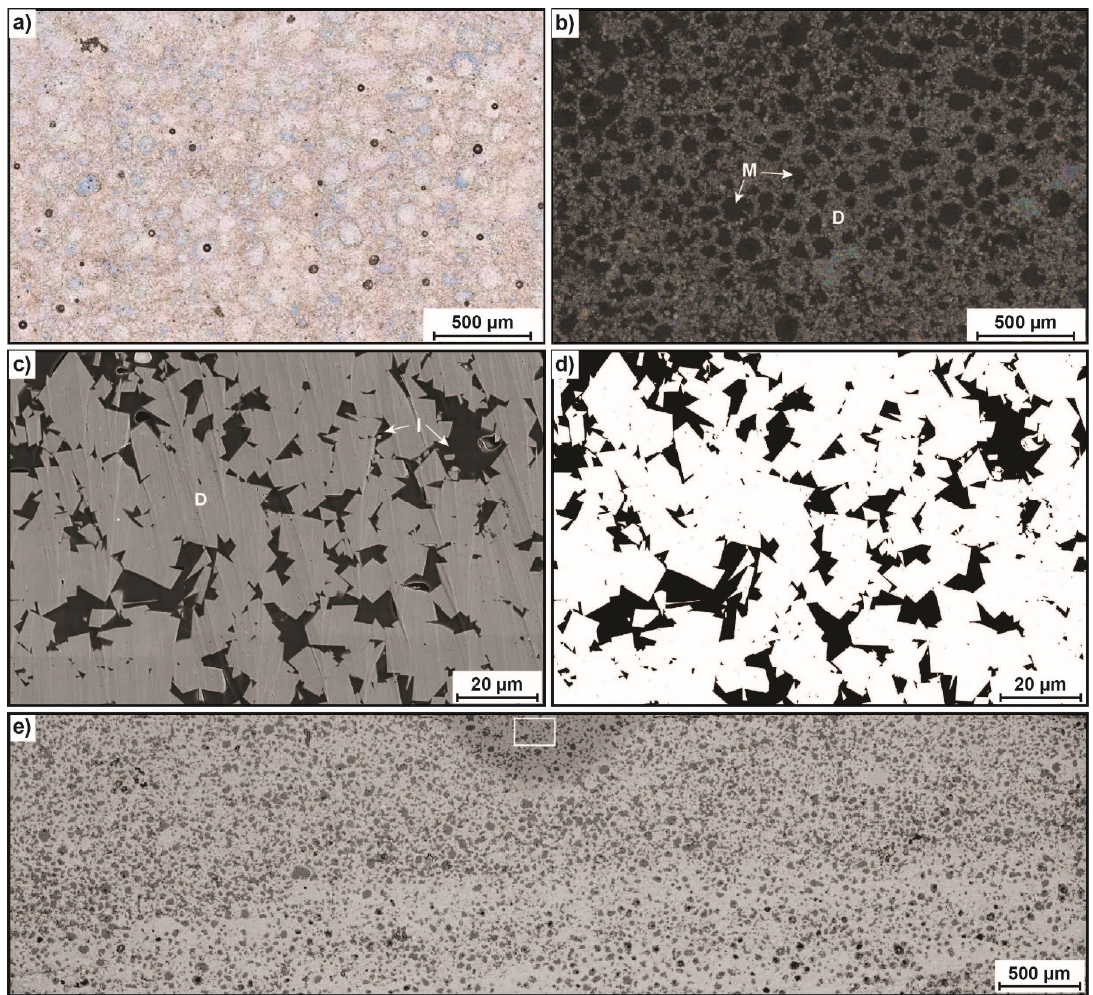
Figure 5. Petrographic observations of shoal oolitic dolograinstone sample 383. Thin-section images ( a ) (plane-polarized) and ( b ) (cross-polarized) show dissolved or partly dissolved ooids, i.e., moldic porosity (M), which are major contributors to total porosity. ( c ) High resolution mosaic within the BIB-polished area stitched from 271 images. Compared to the thin-section images, not only macro- and mesopores (molds) but also (intercrystalline (I)) micro- and nanopores, hosted by aphanocrystalline to medium-crystalline dolomite (D), are visible. ( d ) Binarized version of high-resolution image ( c ) used for image analysis (Figure 7b). ( e ) Large scale mosaic stitched from 185 images. The position of detail images ( c ) and ( d ) is indicated within the BIB-polished area.